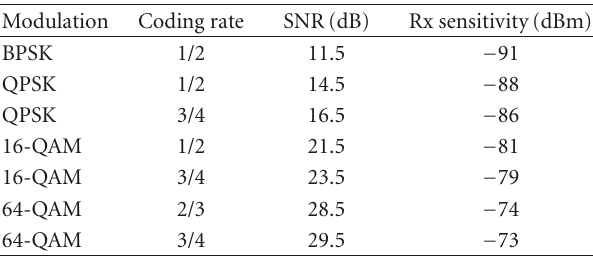
Table 2: Rx sensitivity for the subscriber terminal of the WiMAX system for 3.5 MHz channel width (BER = 10 − 6 , AWGN channel).